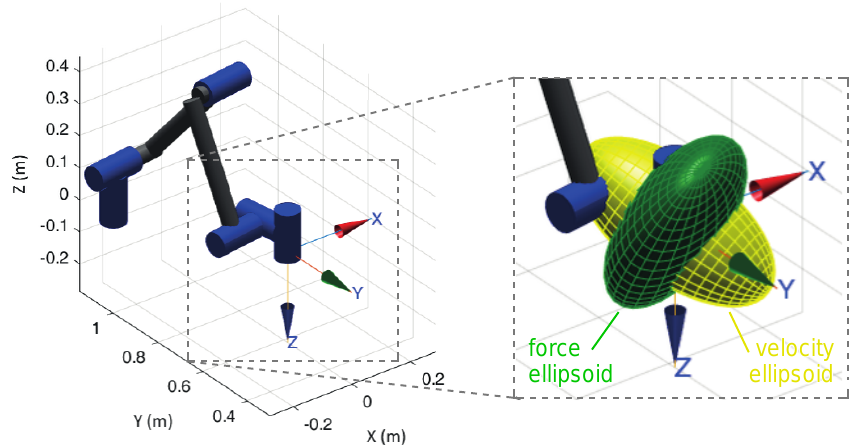
Figure 5. Example of ellipsoids of manipulability for the robot UR5e.